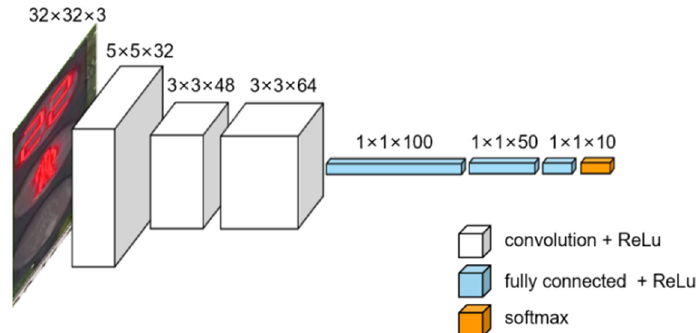
Figure 9. Architecture of the traffic light detection model.